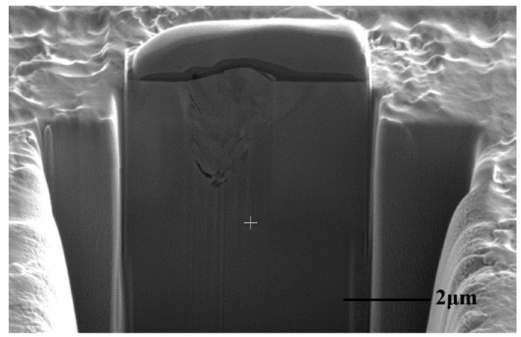
Figure 5. Focused ion beam (FIB) cross-section imaging of nanocrystalline W film after deuterium plasma irradiation.